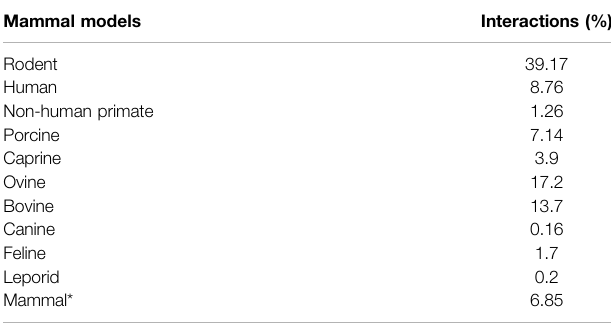
TABLE 1 | WoS_MMivF database incidence of different mammal models. Mammal